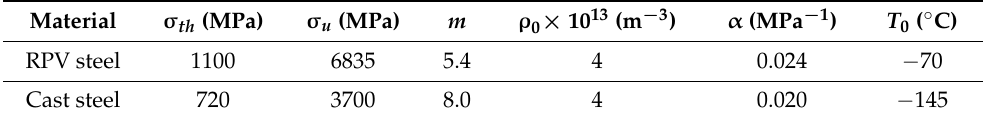
Table 3. Calculation findings ( σ th is the threshold stress; m and σ u are the shape and scale parameters; ρ α are the coefficients; T 0 is the reference 0 and